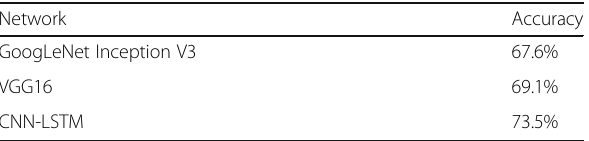
Table 3 Accuracy of different networks